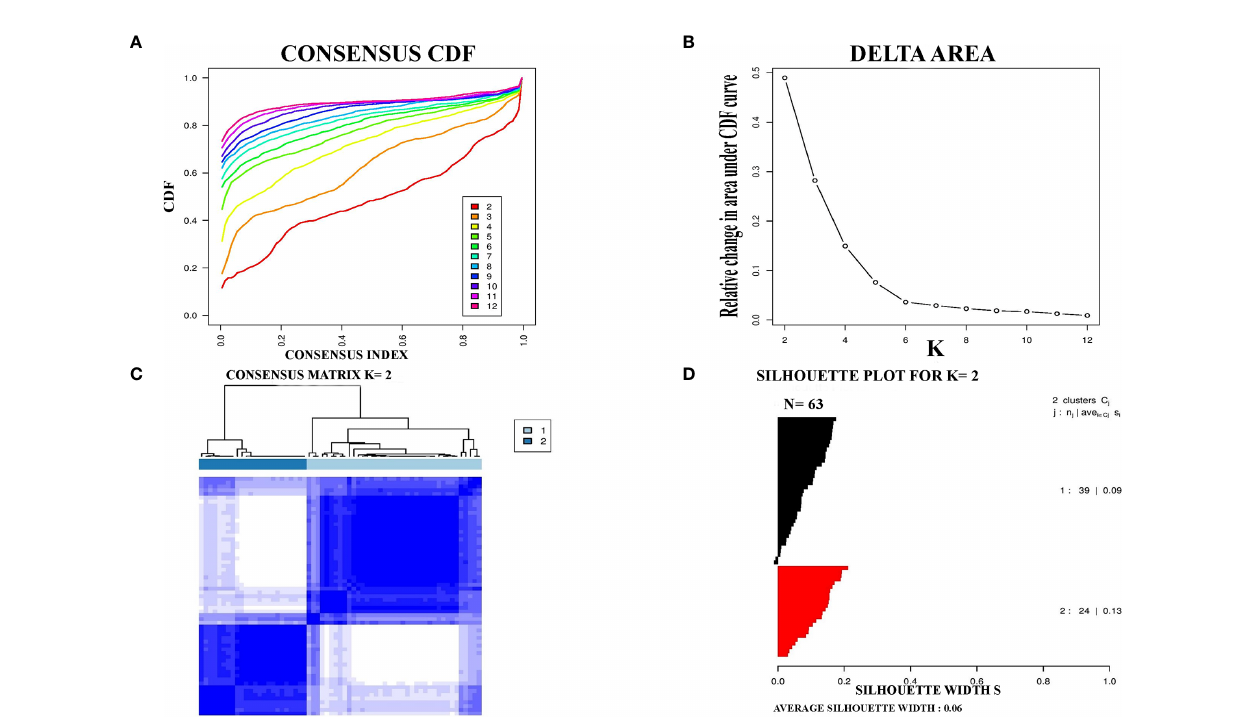
FIGURE 2 | Identi fi cation of two molecular subtypes in GSE19422 cohort of PCC. (A) The optimal number of PCC molecular subtypes was de fi ned through Empirical cumulative plot. (B) Comparative increase in the area under the CDF curve with the increasing expected number of molecular subtypes. (C) Consensus clustering matrix of the two PCC subtypes. (D) Silhouette plot of PCC samples based on Consensus clustering assignment.